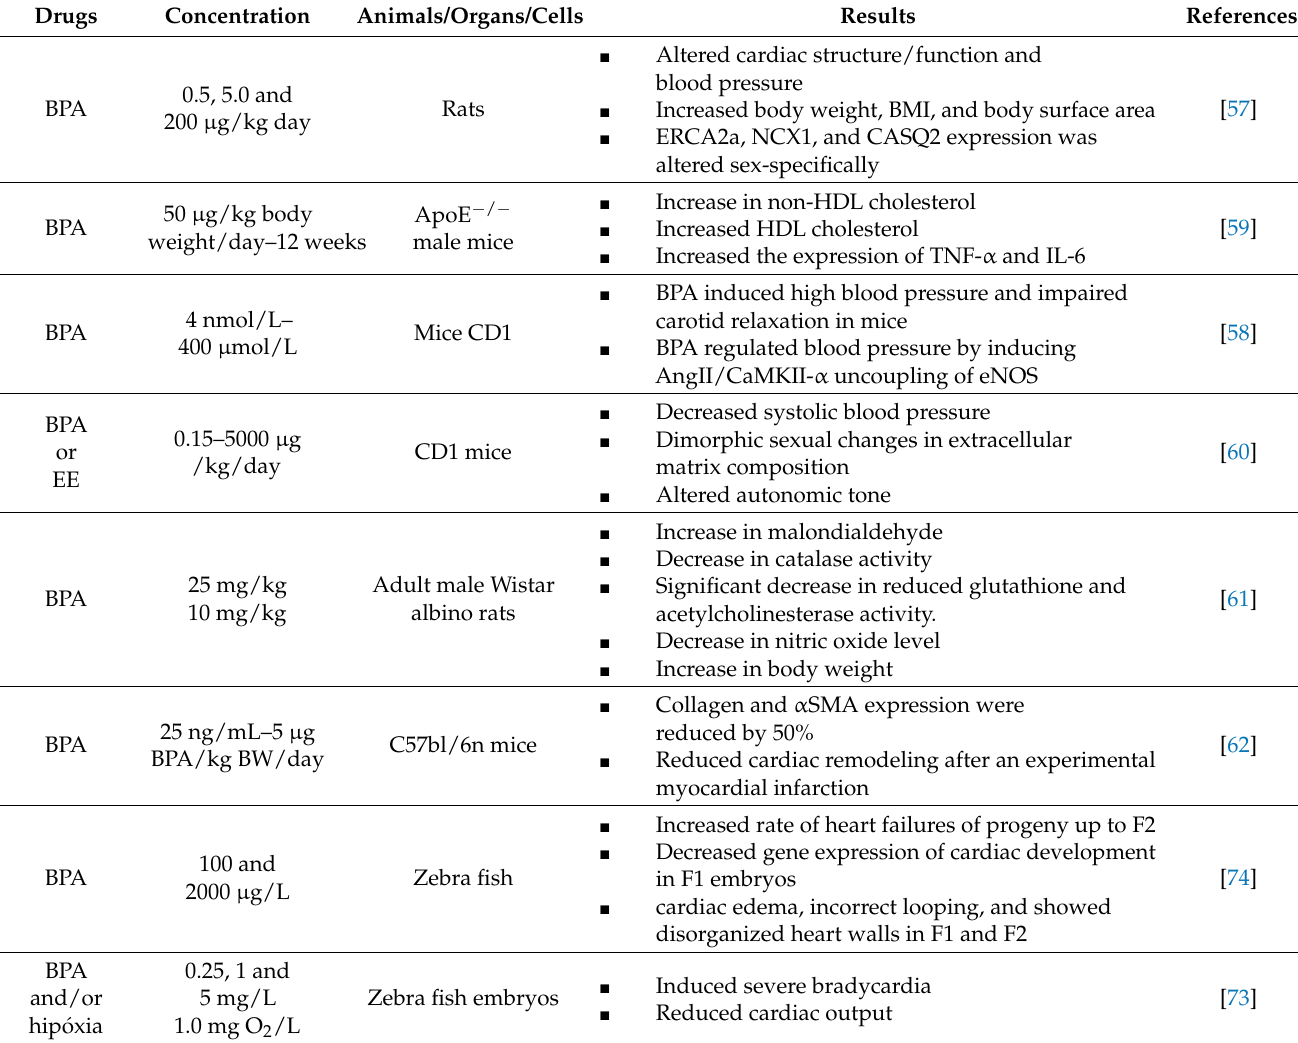
Table 3. Summaries of the disruptive effects of BPA in the animal in vivo studies 1